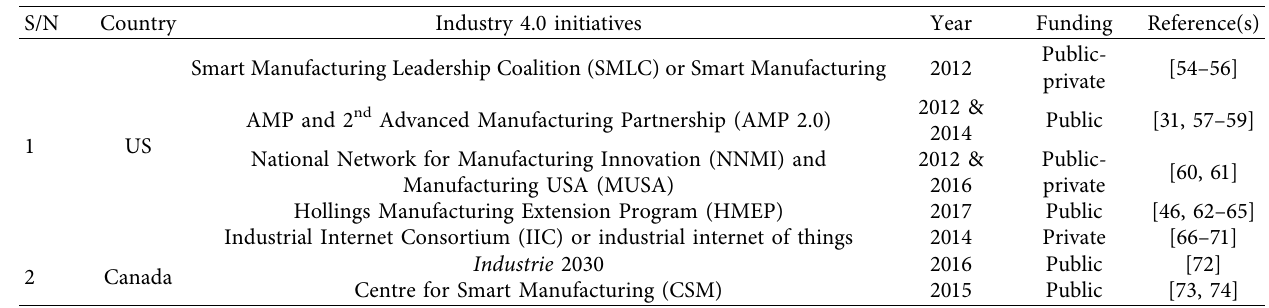
Table 2: Industry 4.0 initiatives launched in North